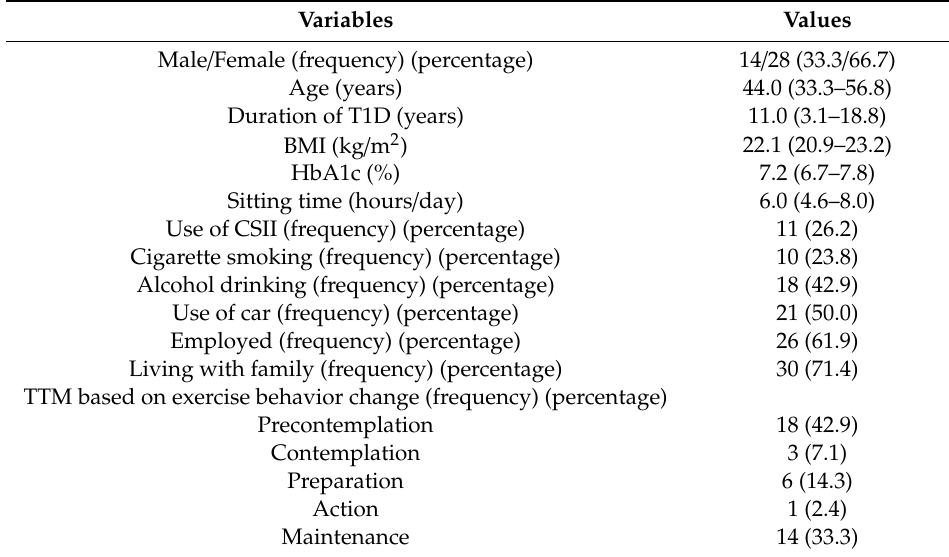
Table 1. Characteristics of the study participants ( n = 42).